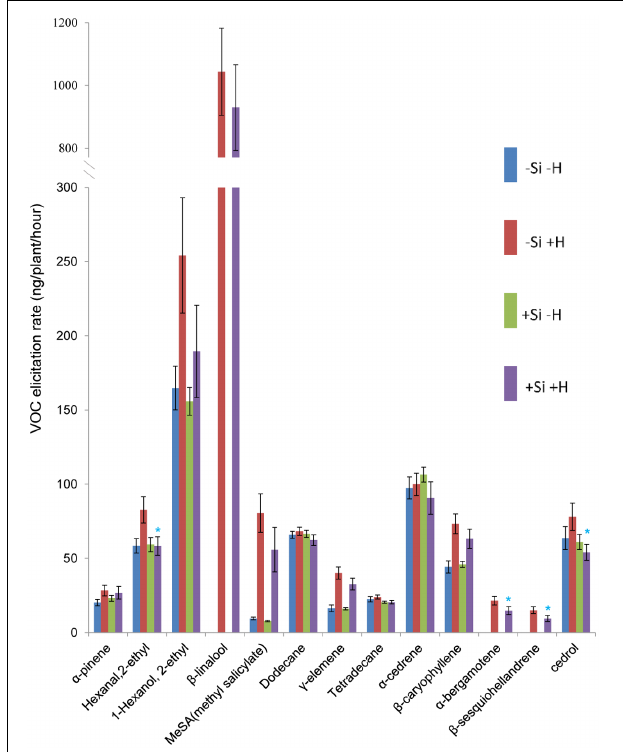
FIGURE 1 | Effect of herbivore (H) ( C. medinalis ) infestation and silicon (Si) treatment on volatile organic compound (VOC) production by wild type rice plants. [Mean ± SE; ∗ , significant effect of silicon within herbivore treatment ( P < 0.05) by Fisher’s Least Significant Difference test of one-way analysis of variance